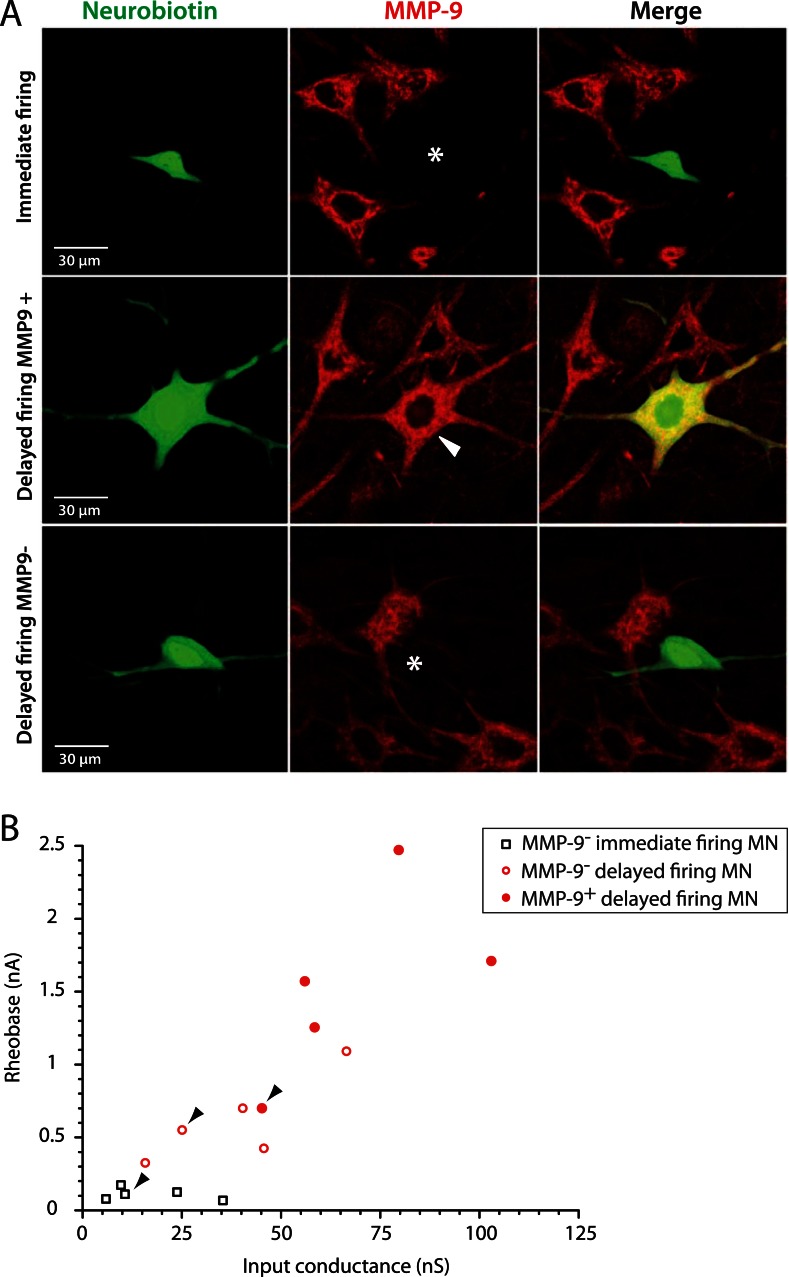
The largest delayed firing motoneurons express MMP9 contrary to immediate firing motoneurons.(A) Examples of MMP9 labelling in neurobiotin filled motoneurons (green). The asterisks in the first and third rows indicate the cell body of the recorded motoneurons devoid of MMP9 expression. The arrowhead in the second row indicates that MMP9 was expressed in this delayed firing motoneuron. (B) Plot of the rheobase against the input conductance for the investigated motoneurons. Half of the delayed firing motoneurons (the ones that display the highest rheobases and input conductances) were MMP9-positive. All the immediate firing motoneurons were MMP9-negative. Arrowheads point to the motoneurons illustrated in A.